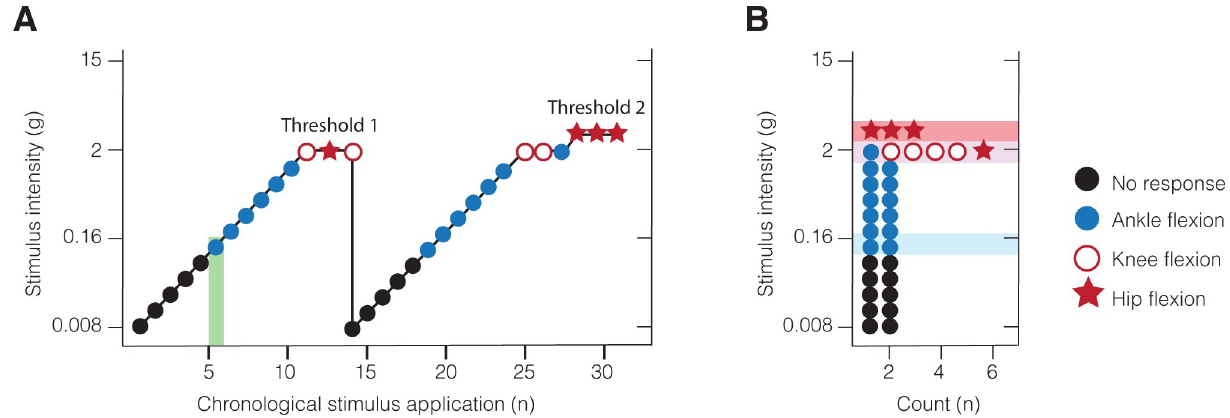
Fig 2. Study design. (A) Schematic of Tactile Sensitivity paradigm in an example subject. Tactile sensitivity threshold, identified as the force required to evoke the first response, is shown in green shaded area (i.e. stimulus # 6 using a force of 0.16g). Nociceptive threshold is marked as “Threshold 1” and “Threshold 2”. (B) Frequency distribution of motor-responses in an example subject. The lowest stimulus intensity required to generate reproducible (a) ankle-flexion, (b) knee-flexion or (c) hip-flexion using data from all trials is determined (shaded areas show in corresponding colour as appropriate). Black circle represents no response, blue circle represents ankle-flexion, pink circle represents knee flexion, and red star represents hip-flexion.